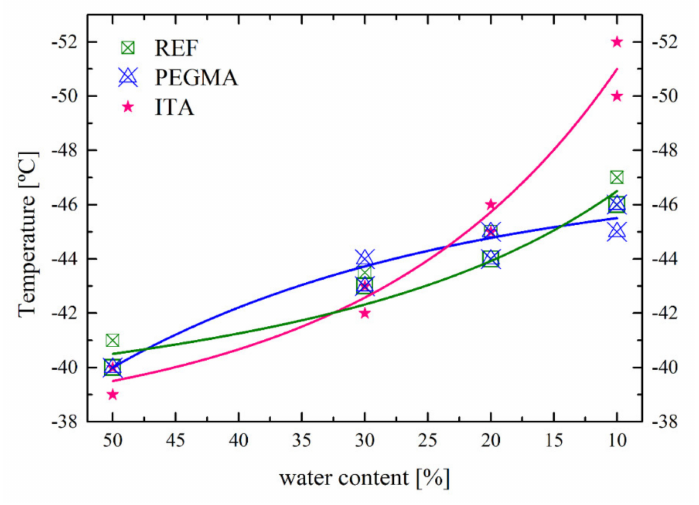
Figure 13. Freezing temperature of bound water for REF, ITA and PEGMA latexes during the